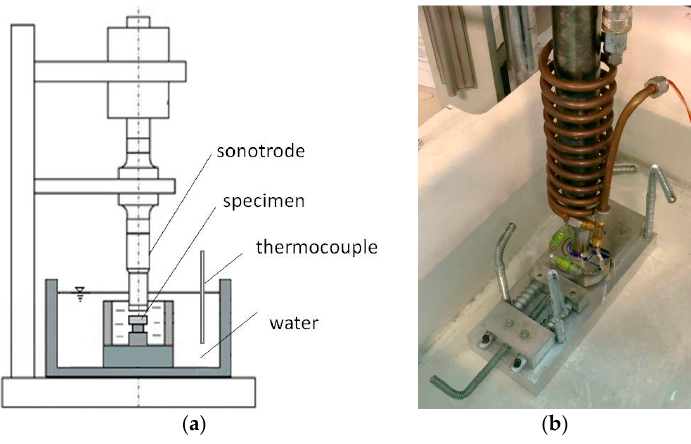
Figure 2. Sketch of the US apparatus ( a ) and view of the holding system ( b ).